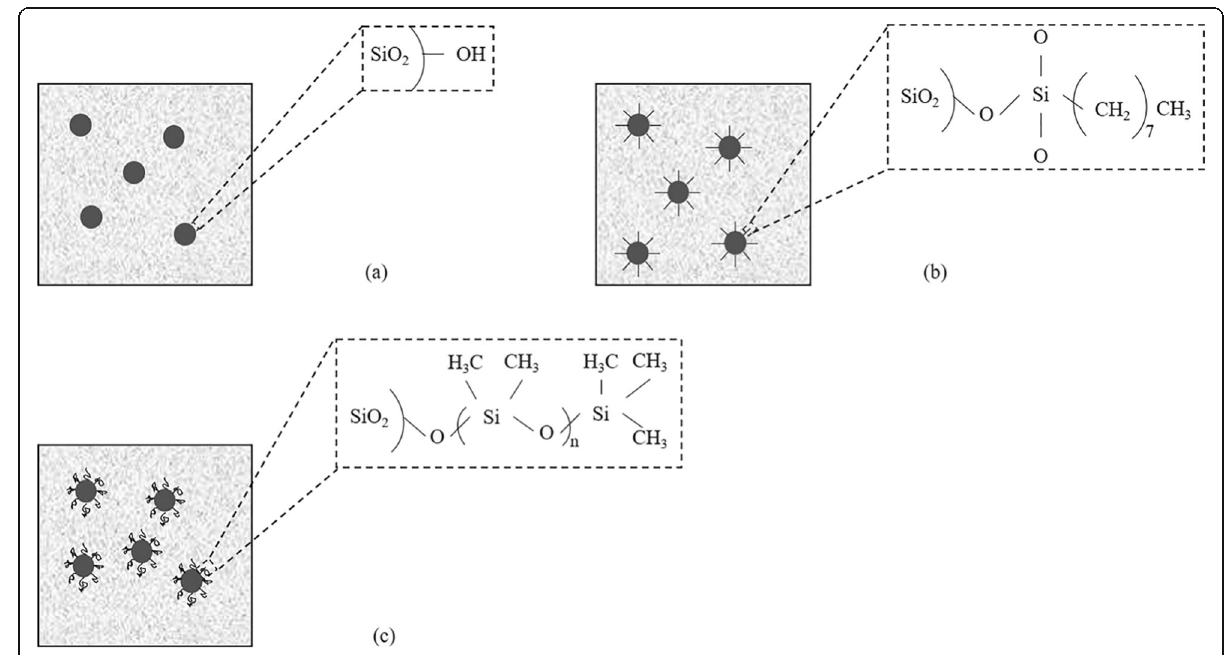
Fig. 3 Replacement of -OH group ( a ) using octyl silane ( b ) and polydimethylsiloxane ( c )